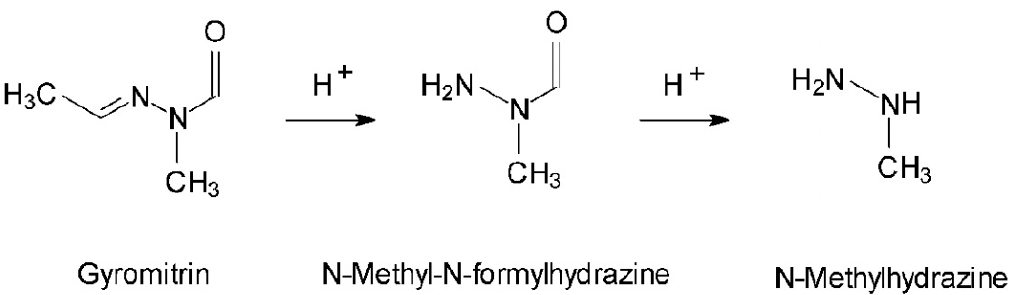
Figure 10. Structure of gyromitrin and its metabolites [209].